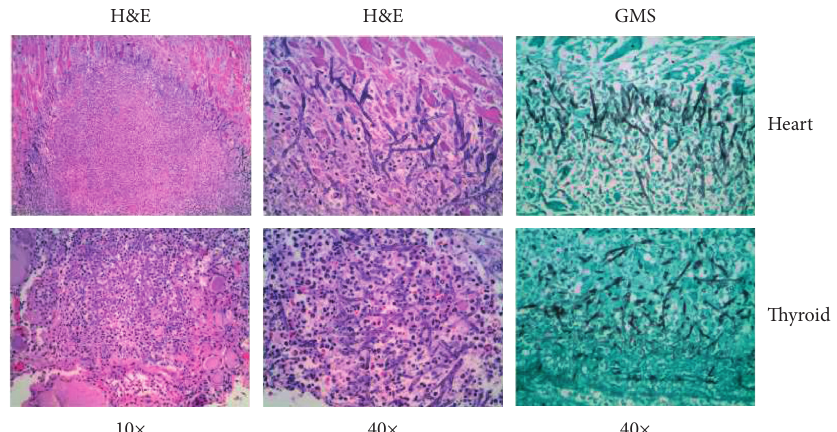
Figure 3: The heart and thyroid tissue display mycetomas. Fungal hyphae are spreading at the peripheral of the lesions. The center of the lesions shows prominent inflammation with neutrophilic infiltration and destruction of the cardiac myocytes (upper panel) and thyroid tissue (lower